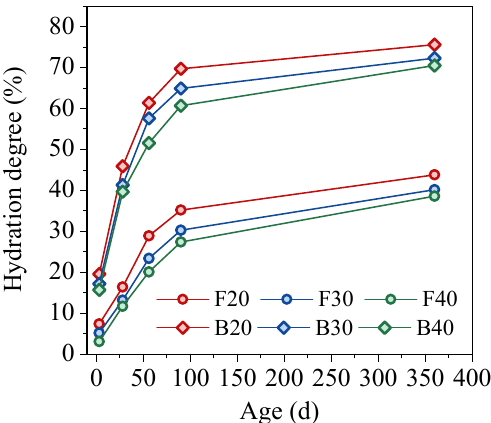
Figure 3. The hydration degrees of FA and GGBS in the composite cement pastes corresponding to the concrete with an equal 28-day strength grade.